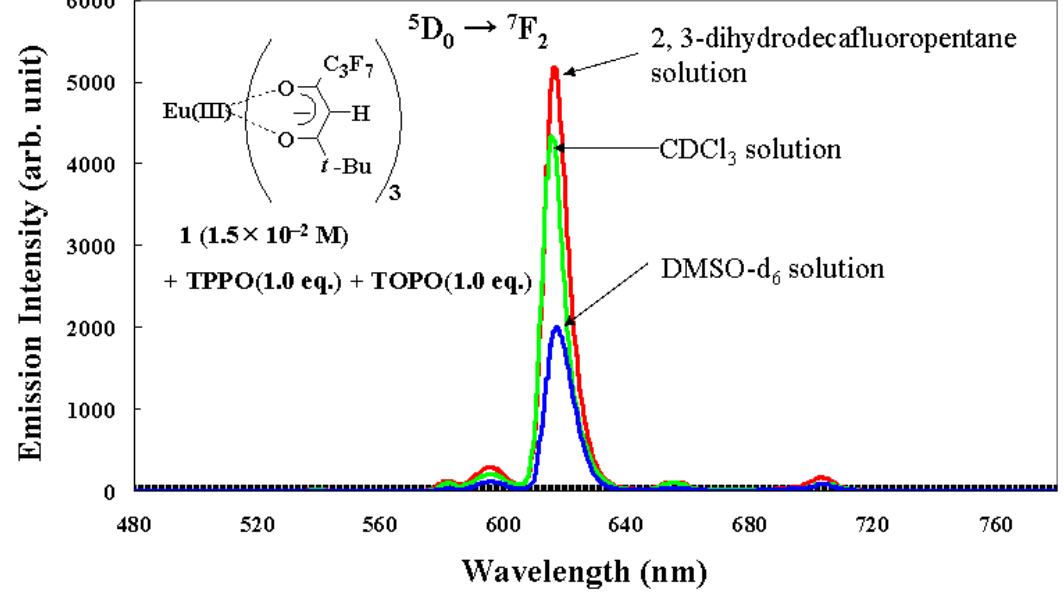
, and DMSO-d excited at 395 nm at room 3 6